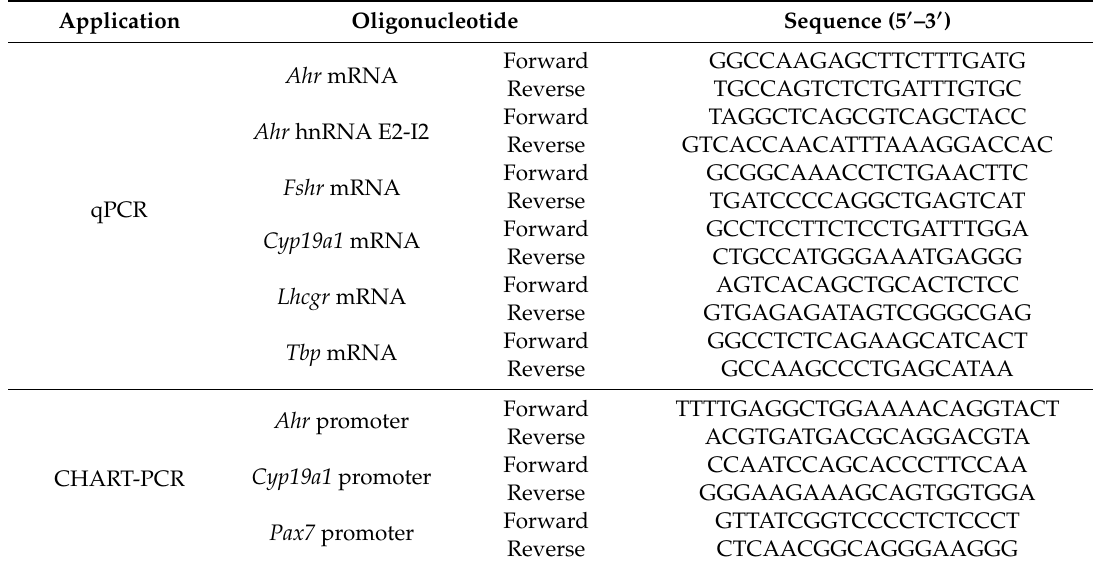
Table 1. Oligonucleotides used in the